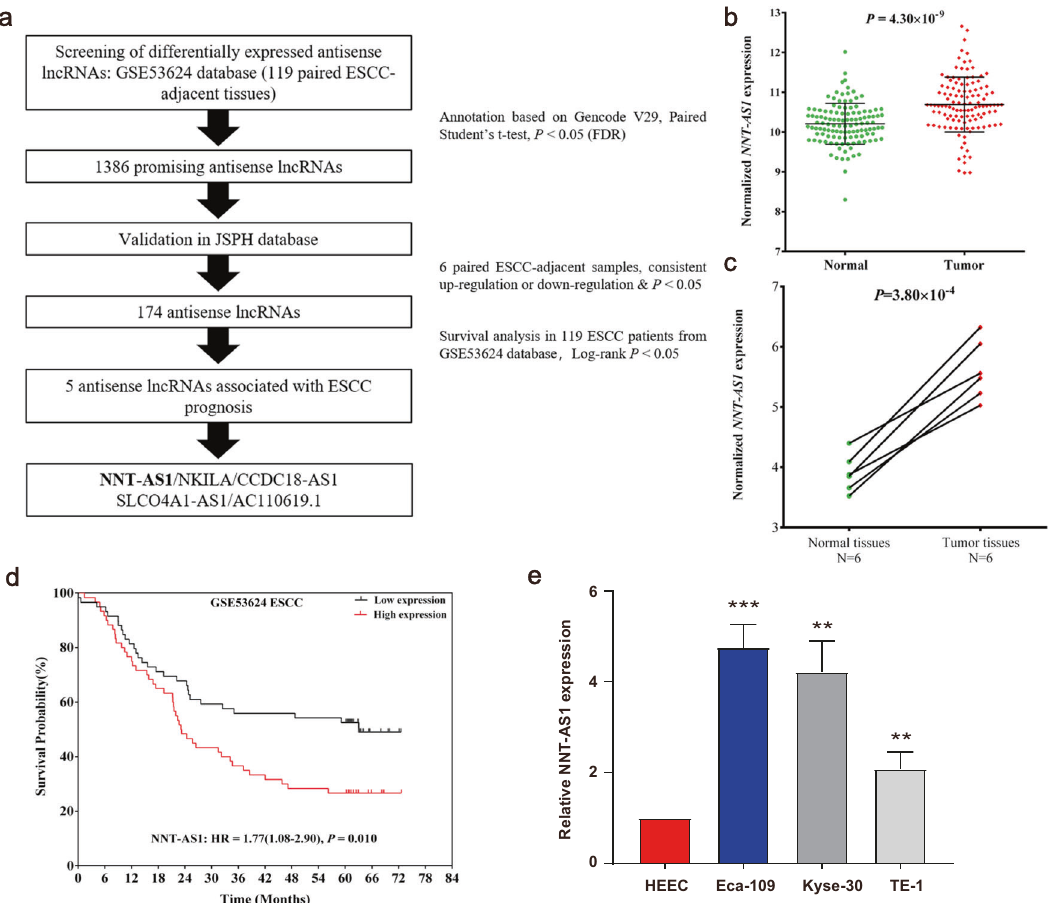
Fig. 1 NNT-AS1 was aberrantly upregulated in ESCC and associated with poorer ESCC prognosis. a The screening process of NNT-AS; b , c NNT-AS1 expression was upregulated in ESCC tissues ( b GSE53624, c JSPH, paired Student ’ s t -test); d high expression of NNT-AS1 was signi fi cantly associated with an inferior ESCC prognosis (Log-rank test); e the expression level of NNT-AS1 in ESCC cell lines (Eca-109, Kyse-30, and TE-1) was signi fi cantly higher than that in the human normal esophageal epithelial cell line (HEEC) (unpaired Student ’ s t -test). The results were from three independent experiments. *** P < 0.001, ** P < 0.01. Variables were presented as the Mean ± SD (Standard enrichment analysis was performed. As shown in Fig. 7e, NNT might participate in multiple signaling pathways, including the cell cycle pathway, one of the central pathways in cancers. This result was consistent with the above fl ow cytometry fi ndings. Western blot assays indicated that NNT-AS1 and NNT silencing could suppress the levels of CCNB1, CCNB2, CDK1, and CDK2 (Fig. 7f). Taken together, NNT-AS1 contributed to ESCC initiation and development through regulating the cell cycle pathway. DISCUSSION In this study, we evaluated the roles of antisense lncRNAs in ESCC through a systematic analysis. As a result, NNT-AS1 was found aberrantly upregulated in ESCC and was signi fi cantly associated with a poorer prognosis. Functionally, we found that NNT-AS1 might contribute to ESCC progression through positively regulat- ing its sense gene NNT expression by sponging miR-382-5p. NNT-AS1, located in 5p12, has been veri fi ed to play a carcinogenic role in multiple malignant tumors, including lung squamous cell carcinoma, cervical cancer, gastric cancer, and so on. Ma et al discovered that NNT-AS1 accelerated the progression of lung squamous cell carcinoma by positively modulating FOXM1, a member of the FOX transcription factor family [23]. Li et al revealed that NNT-AS1 facilitated breast cancer progression by regulating ZEB1 expression through sponging miR-142-3p [24].